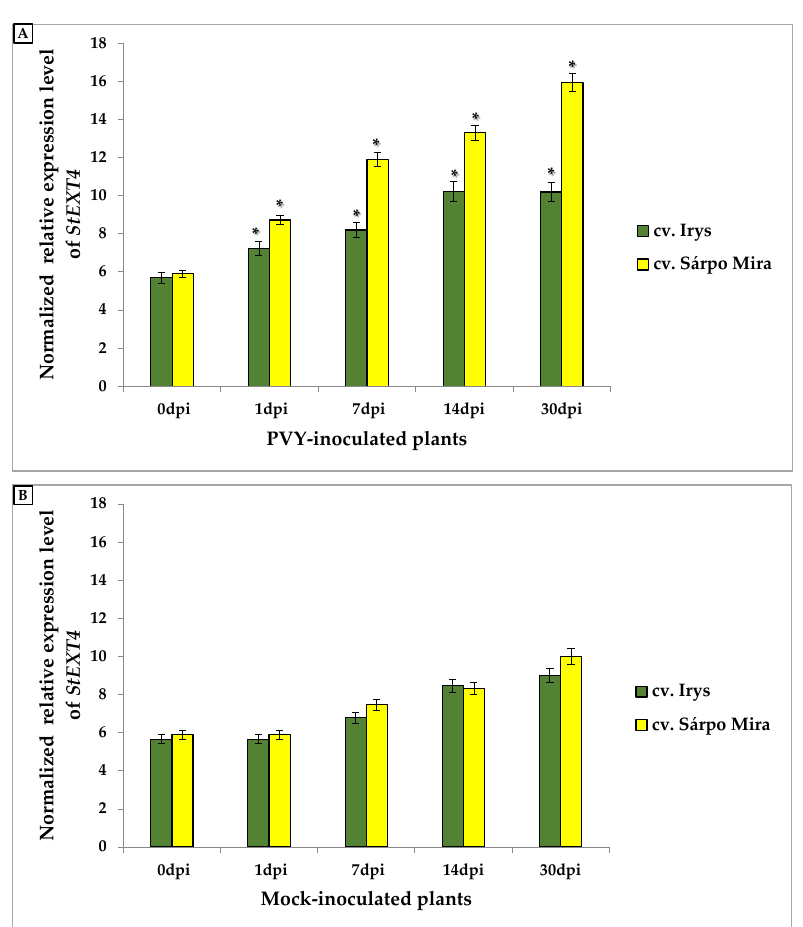
Figure 6. The normalized relative expression level of StEXT4 in PVY-inoculated plants calculated based on the reference gene, StEf1 α ( A ) and in mock-inoculated ( B ) Irys and S á rpo Mira leaves at 1, 7, 14, and 30 dpi, in combination with ANOVA. Mean values of normalized expression levels were evaluated at the p < 0.05 level of significance using a post-hoc Tukey HSD test. Statistically significant values on di ff erent days after mock or virus inoculation for the cultivars are marked by asterisks (*) above the mean value of the normalized expression on each